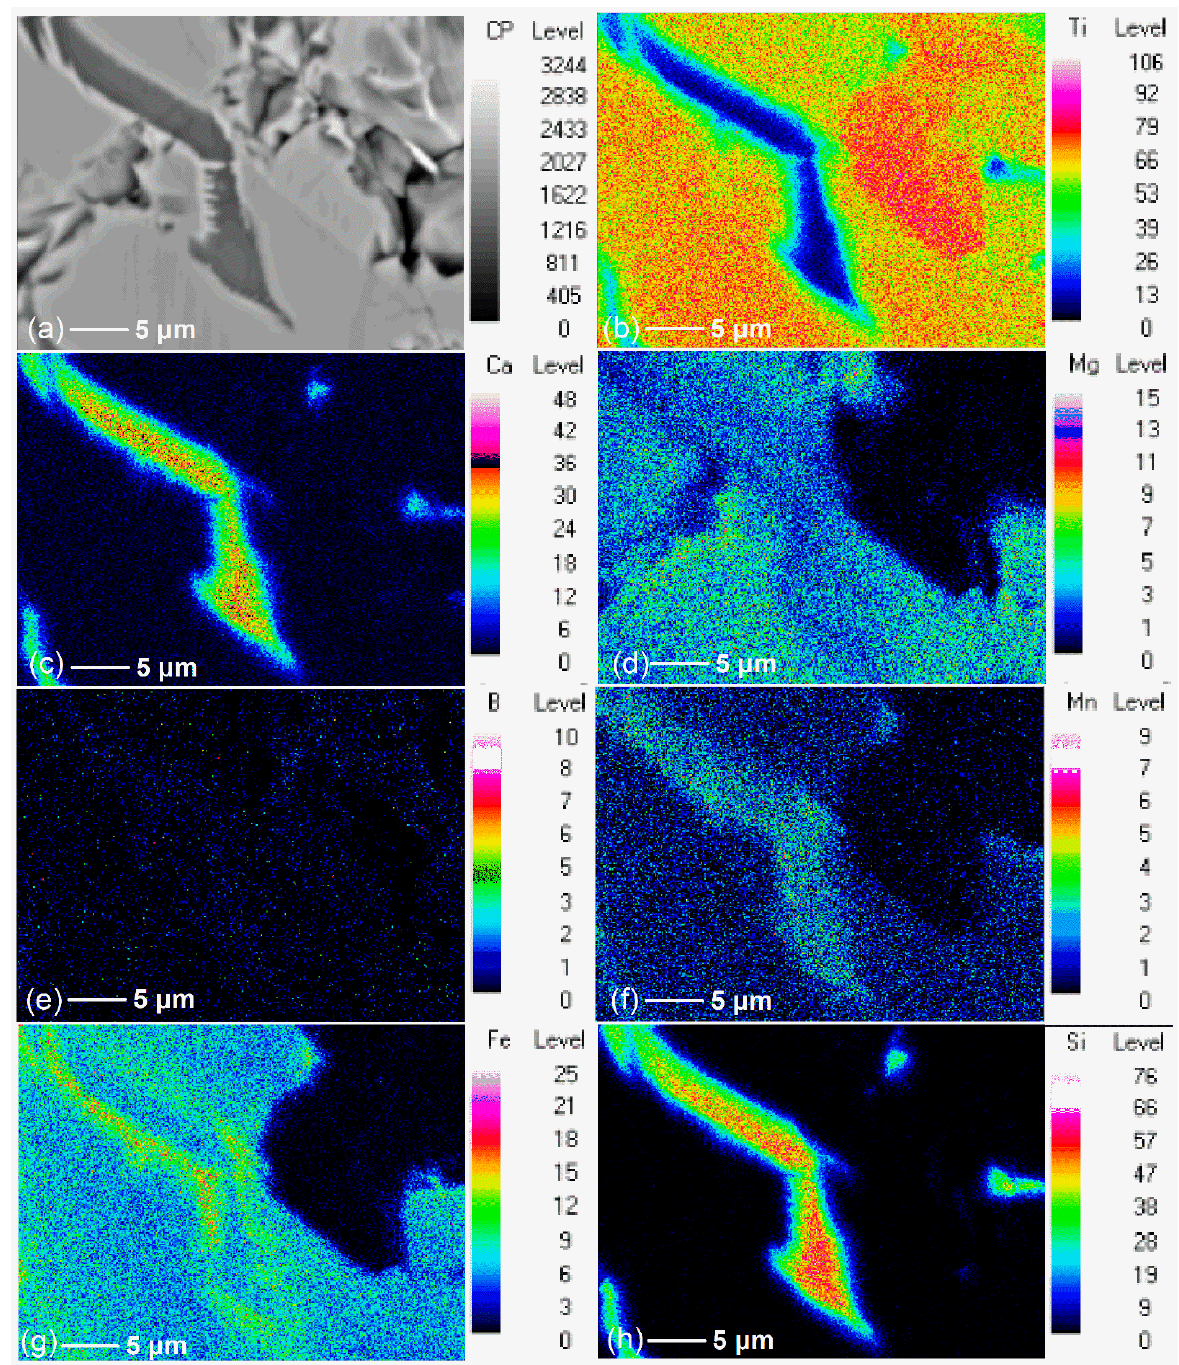
Figure 4. WDS mapping analysis of the cross-section of block sample of the modified titanium slag with the additive (B 2 O 3 ) amount of 2%: ( a ) total, ( b ) Ti, ( c ) Ca, ( d ) Mg, ( e ) B, ( f ) Mn, ( g ) Fe, and ( h ) Si. WDS mapping analysis of the cross-section of the block sample of the modified titanium slag with the additive (B 2 O 3 ) amount of 4% is displayed in Figure